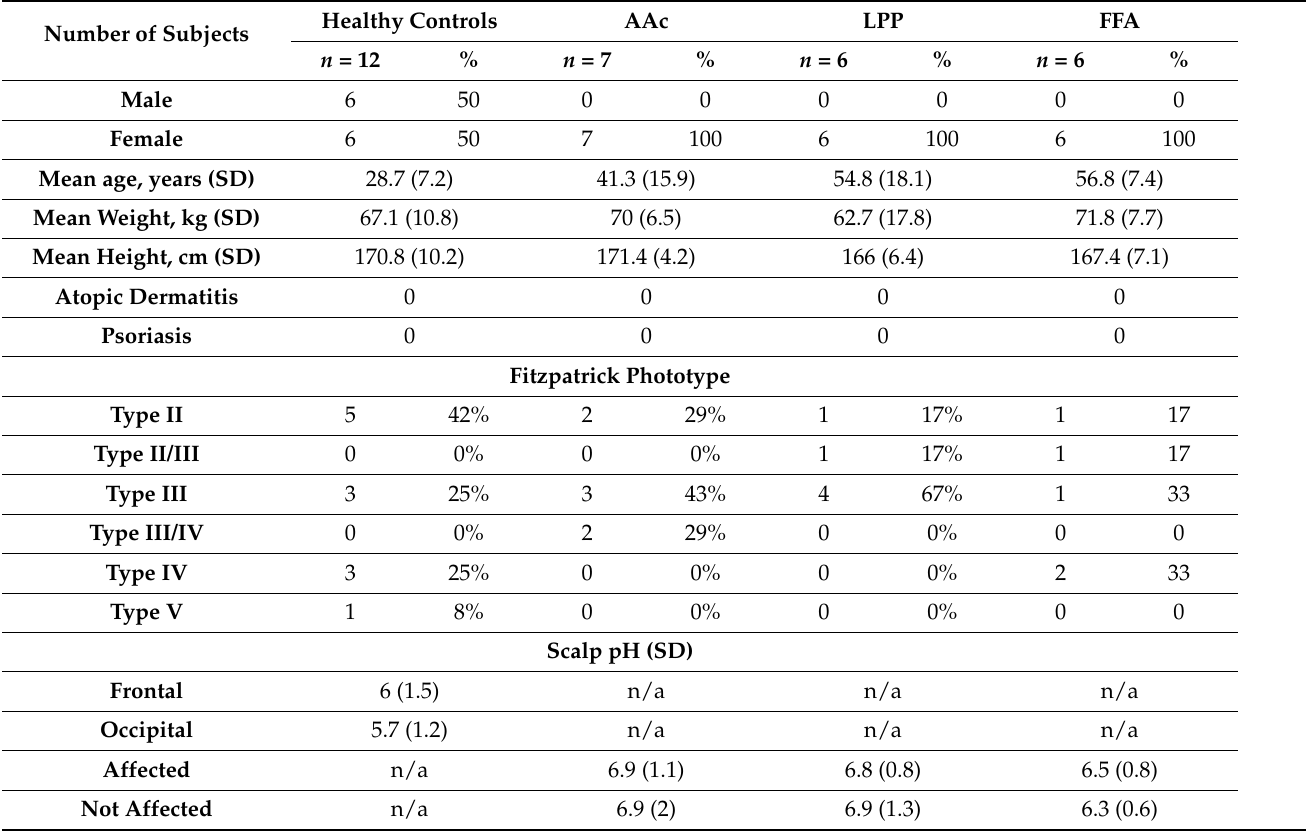
Table 1. Subject demographics and clinical data